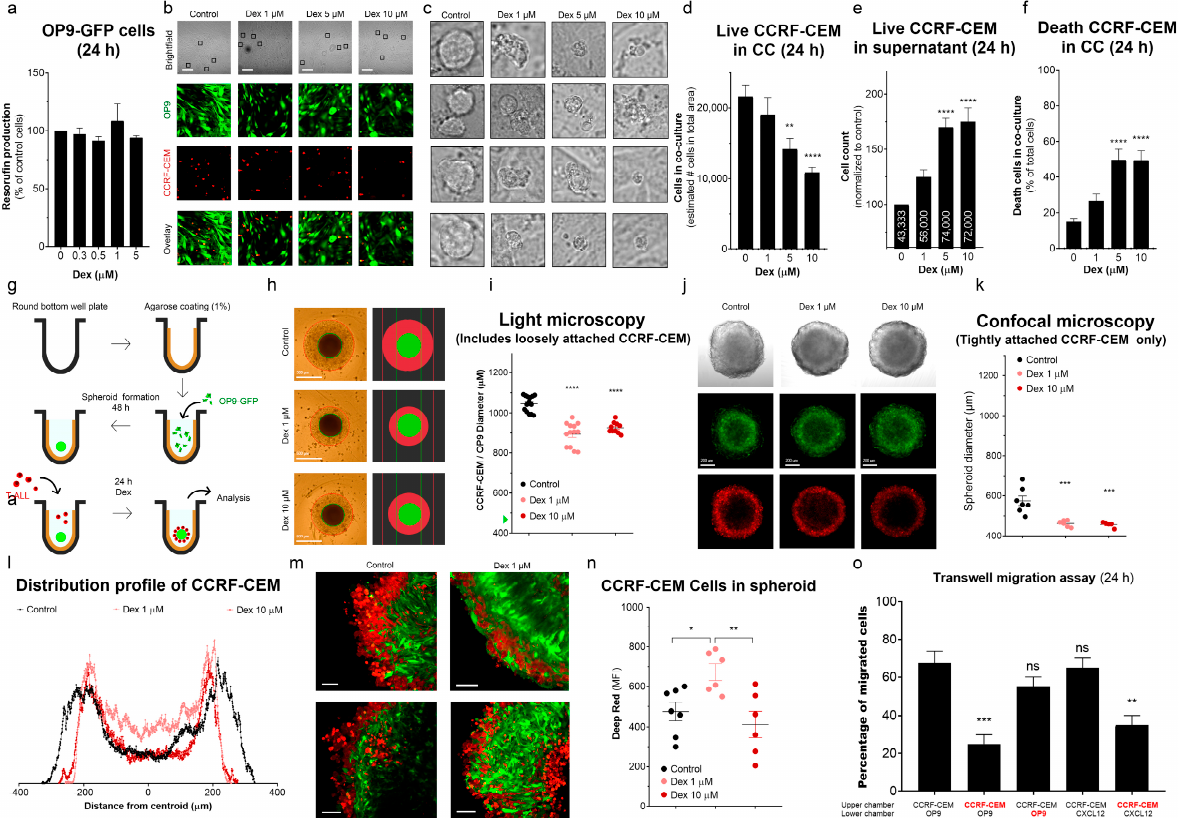
Figure 6. Effects of Dex on T-ALL in (CCRF-CEM) MSCs (OP9) co-cultures. ( a ) Effect of Dex (0–5 µ M, 24 h) on the metabolism of the OP9-GFP cells. Data are mean ± S.E. of at least 3 independent experiments. Raw data were normalized to control. An independent t -test was performed. ( b ) Representative micrographs of 2D-CC, either untreated or exposed to Dex (24 h). Green: OP9-GFP cells, red: CCRF-CEM cells stained with Deep Red cell tracker. Scale bars: 50 µ m. ( c ) Representative morphology of CCRF-CEM cells on the surface of 2D-CC (from b, brightfield, black squares). ( d ) Quantification of the living CCRF-CEM cells, interacting with the MSCs monolayer, in untreated and Dex-treated (24 h) 2D-CC. ( e ) Quantification of the living CCRF-CEM cells in the supernatant of 2D-CC, either untreated or after exposure for 24 h to Dex. ( f ) Quantification of the dead CCRF-CEM cells in the supernatant of 2D-CC, untreated or after Dex exposure (24 h). In (d-f), an independent t -test was performed. ( g ) Experimental strategy to obtain 3D-CC. ( h ) Representative light microscopy images of intact 3D-CC, untreated or Dex-treated (1 and 10 µ M, 24 h). Scale bars: 200 µ m. ( i ) Quantitation of 3D-CC spheroids’ diameter, untreated or after Dex exposure (1 and 10 µ M, 24 h), light microscopy. ( j ) Representative confocal microscopy micrographs of intact 3D-CC spheroids, untreated and exposed to Dex (1 and 10 µ M, 24 h). Green: OP9-GFP cells, red: CCRF-CEM cells stained with Deep Red. Scale bars: 200 µ m. ( k ) Quantification of 3D-CC spheroids’ diameter, untreated or exposed to Dex (1 and 10 µ M, 24 h). Confocal microscopy. ( l ) Distribution profiles of Deep Red fluorescence (corresponding to CCRF-CEM) intensity across 3D-CC spheroid. The histogram is the average of at least 6 independent experiments. ( m ) Representative high-resolution (40 × ) micrographs of independent 3D-CC spheroids. Green: OP9-GFP cells, red: CCRF-CEM cells stained with Deep Red. Scale bars: 50 µ m. ( n ) Quantitative analysis of the mean fluorescence intensity (MFI) of the CCFR-CEM cells retained in the 3D-CC spheroid. One-way ANOVA with multiple comparison tests was used. ( o ) Effect of Dex (1 µ M) treatment on the migration of CCRF-CEM cells from the upper to the lower chamber. The experimental strategy is specified under the graph: CCRF-CEM or OP9 cells were either pretreated with Dex (1 µ M, 24 h, red font color) or untreated (black font). One-way ANOVA with multiple comparison tests was performed. In ( a , d – f , o ), data are mean ± S.E. for at least 4 independent experiments. * p < 0.05; ** p < 0.01; *** p < 0.001; **** p <